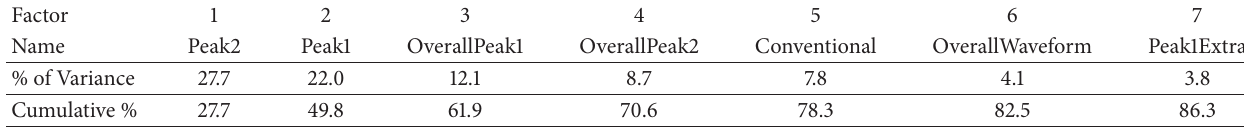
Table 4: Factor analysis of the corneal deformation response curve. Factors are shown on top in the order in which they were extracted (as described in Section 2). Corneal descriptor loadings are summarized for each